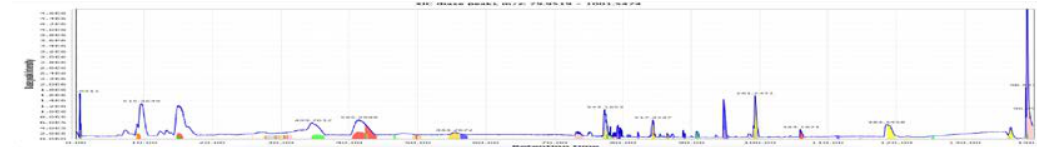
Fig. 3. Extracted ion chromatogram (XIC) of ethyl acetate crude extract of G. boninense after peak deconvolution by local minimum search. Each individual recognized peak within the chromatogram is indicated in different colour with peak intensity and m/z value.